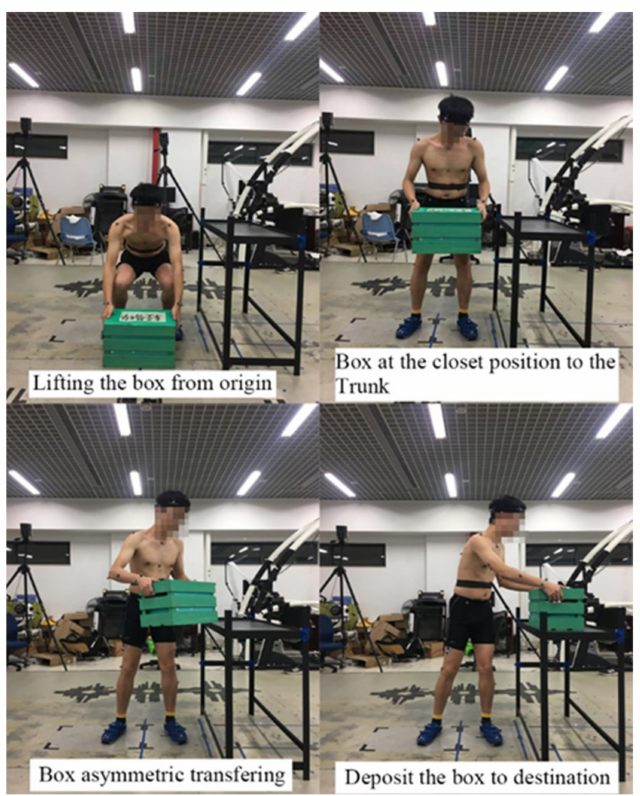
Figure 1. A participant performing the asymmetric lifting